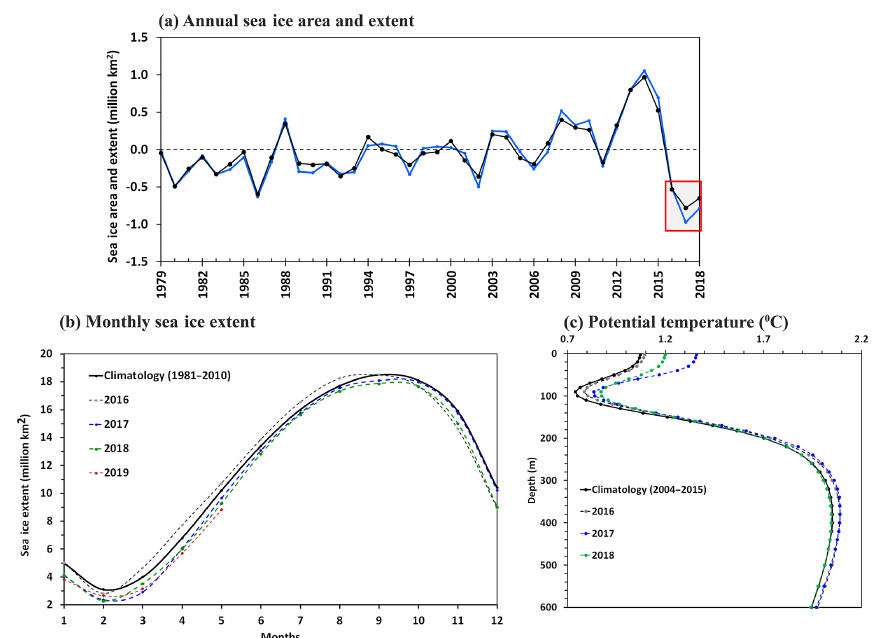
Figure 9. (a) Interannual variability of the Antarctic sea ice area (black) and extent (blue) anomaly relative to the climatology (1979–2015), as analyzed from satellite observations of passive microwave sensors. The red rectangle shows the anomalous record lowest sea ice area and extent observed for 3 successive years from 2016 to 2018, with the maximum melting occurring in 2017. (b) Monthly mean sea ice extent data indicated loss of sea ice that started from September 2016 and continued for the years 2017, 2018, and 2019. (c) Argo-based ocean potential temperature data (2004–2018) indicated anomalous upper ocean warming of the Southern Ocean from 2016 to 2018. The potential temperature was spatially averaged over the south of the 55 ◦ S region encircling Antarctica.